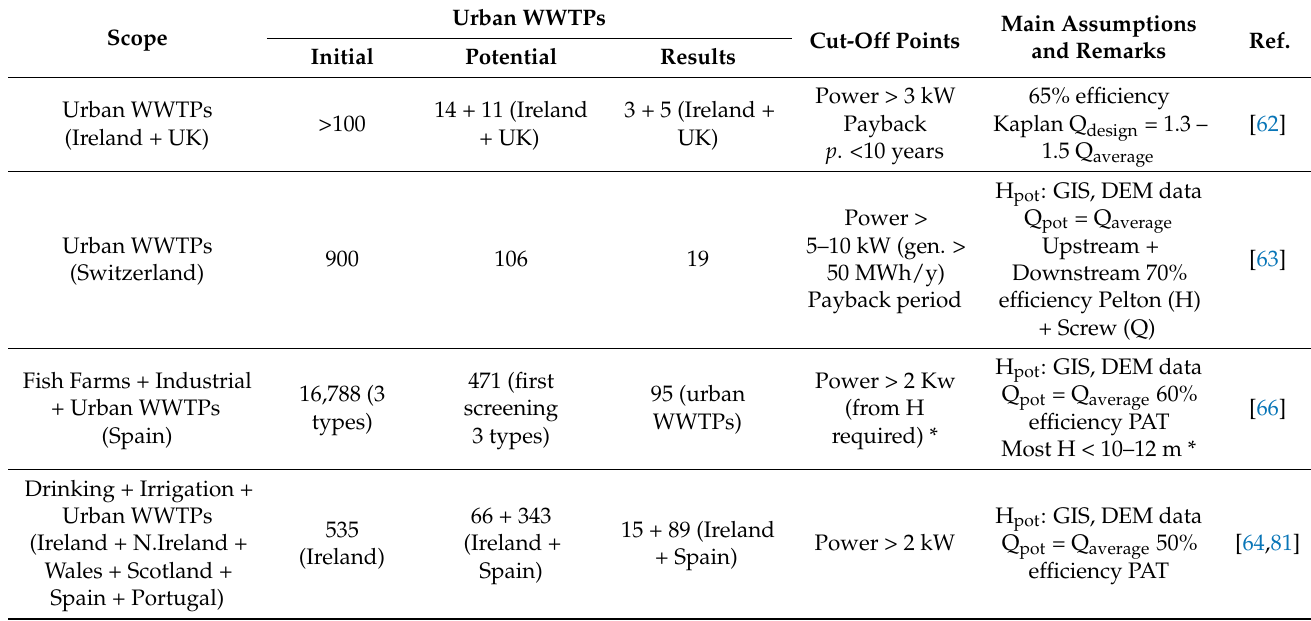
Table 1. Summary of the analyzed methodologies for hydropower potential assessment applied to wastewater